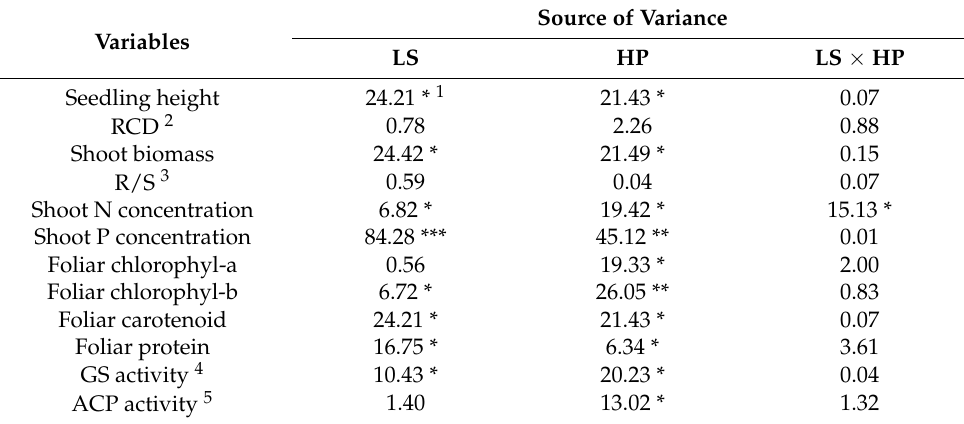
Table 1. F values from the analysis of variance (ANOVA) of light spectra (LS), heterogeneous pattern (HP), and their interaction (LS × HP) on shoot growth, biomass, nitrogen (N) and phosphorus (P) concentrations and contents, and foliar variables in Pinus pumila (Pall.) Regel seedlings.